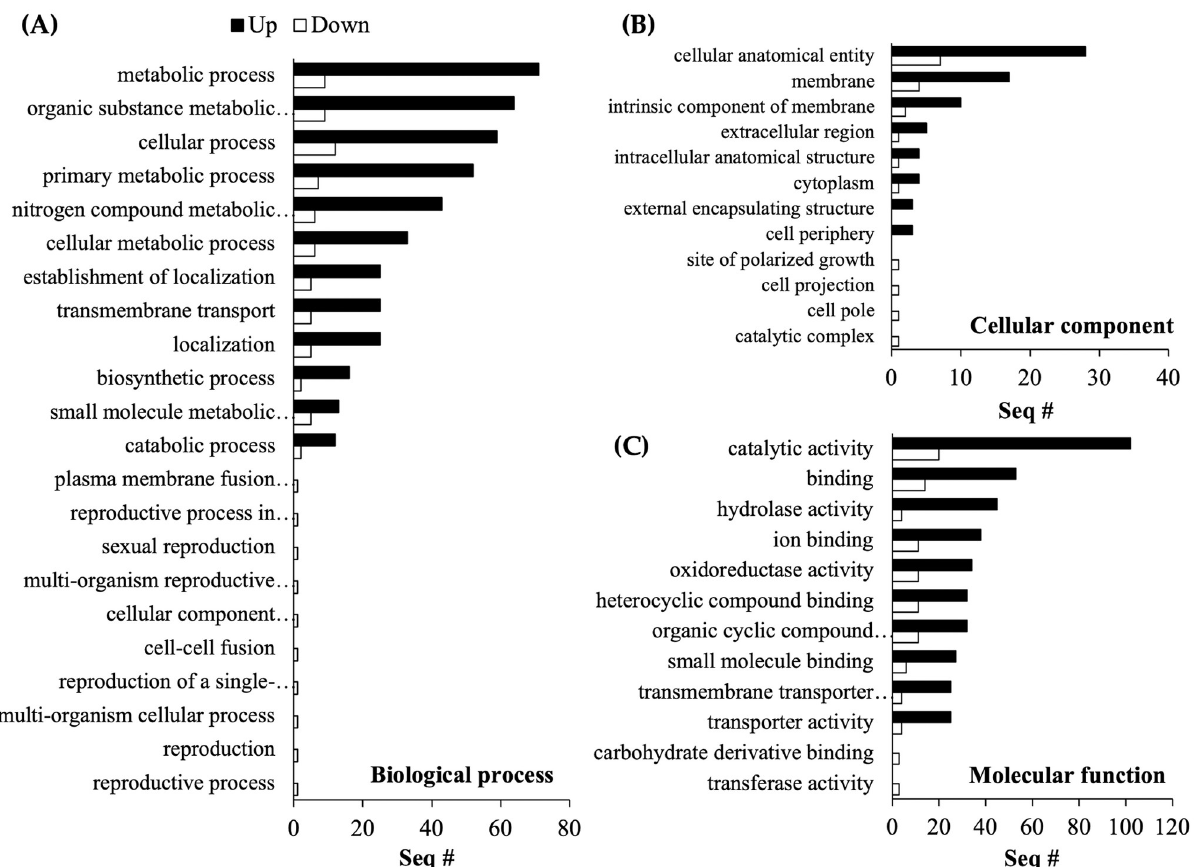
Fig 2. Gene ontology (GO) analysis of B . bassiana JEF-410 DEGs. Gene Ontology (GO) analysis of non-treated control fungus vs. red mite-infecting fungus was conducted. The up- and down-regulated genes were annotated to a biological process (97 and 15), a cellular component (29 and 7), and molecular function (146 and 27). DEGs of red mite-infecting fungus were annotated in three GO groups: (A) biological process (34.9%), (B) cellular component (11.2%), and (C) molecular function